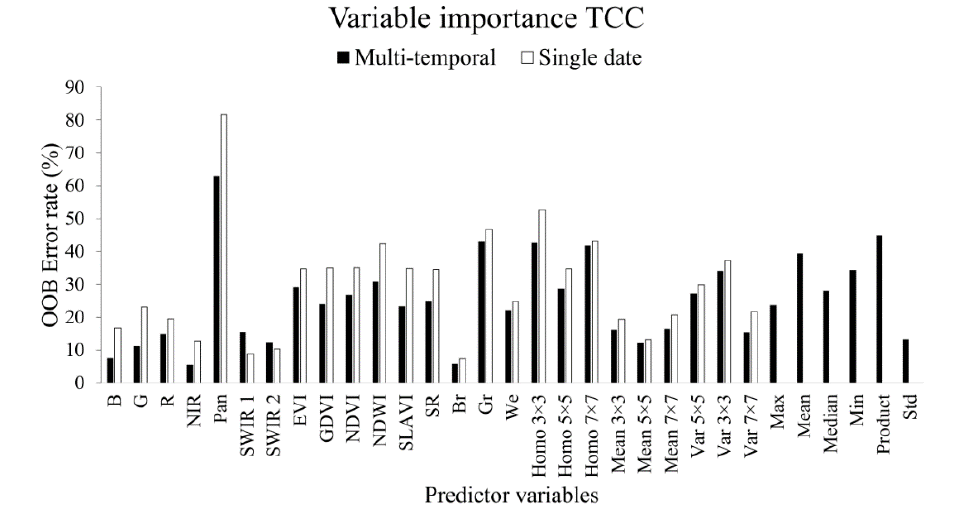
Figure 2. Importance of predictor variables for estimating tree canopy cover (TCC) using multi-temporal and single date imagery. A higher out of bag (OOB) error rate indicates stronger importance of the predictor variables. See Table 4 for description of abbreviations for predictor